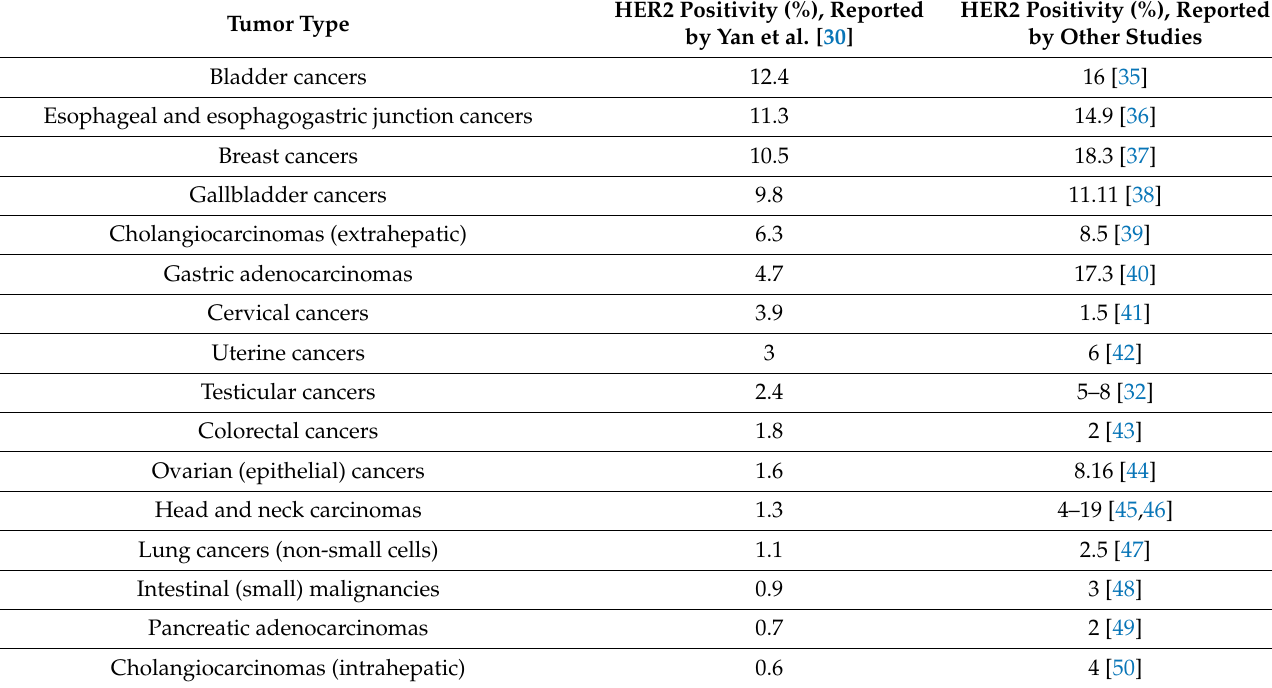
Table 1. Incidence of HER2 positivity in diverse cancers by